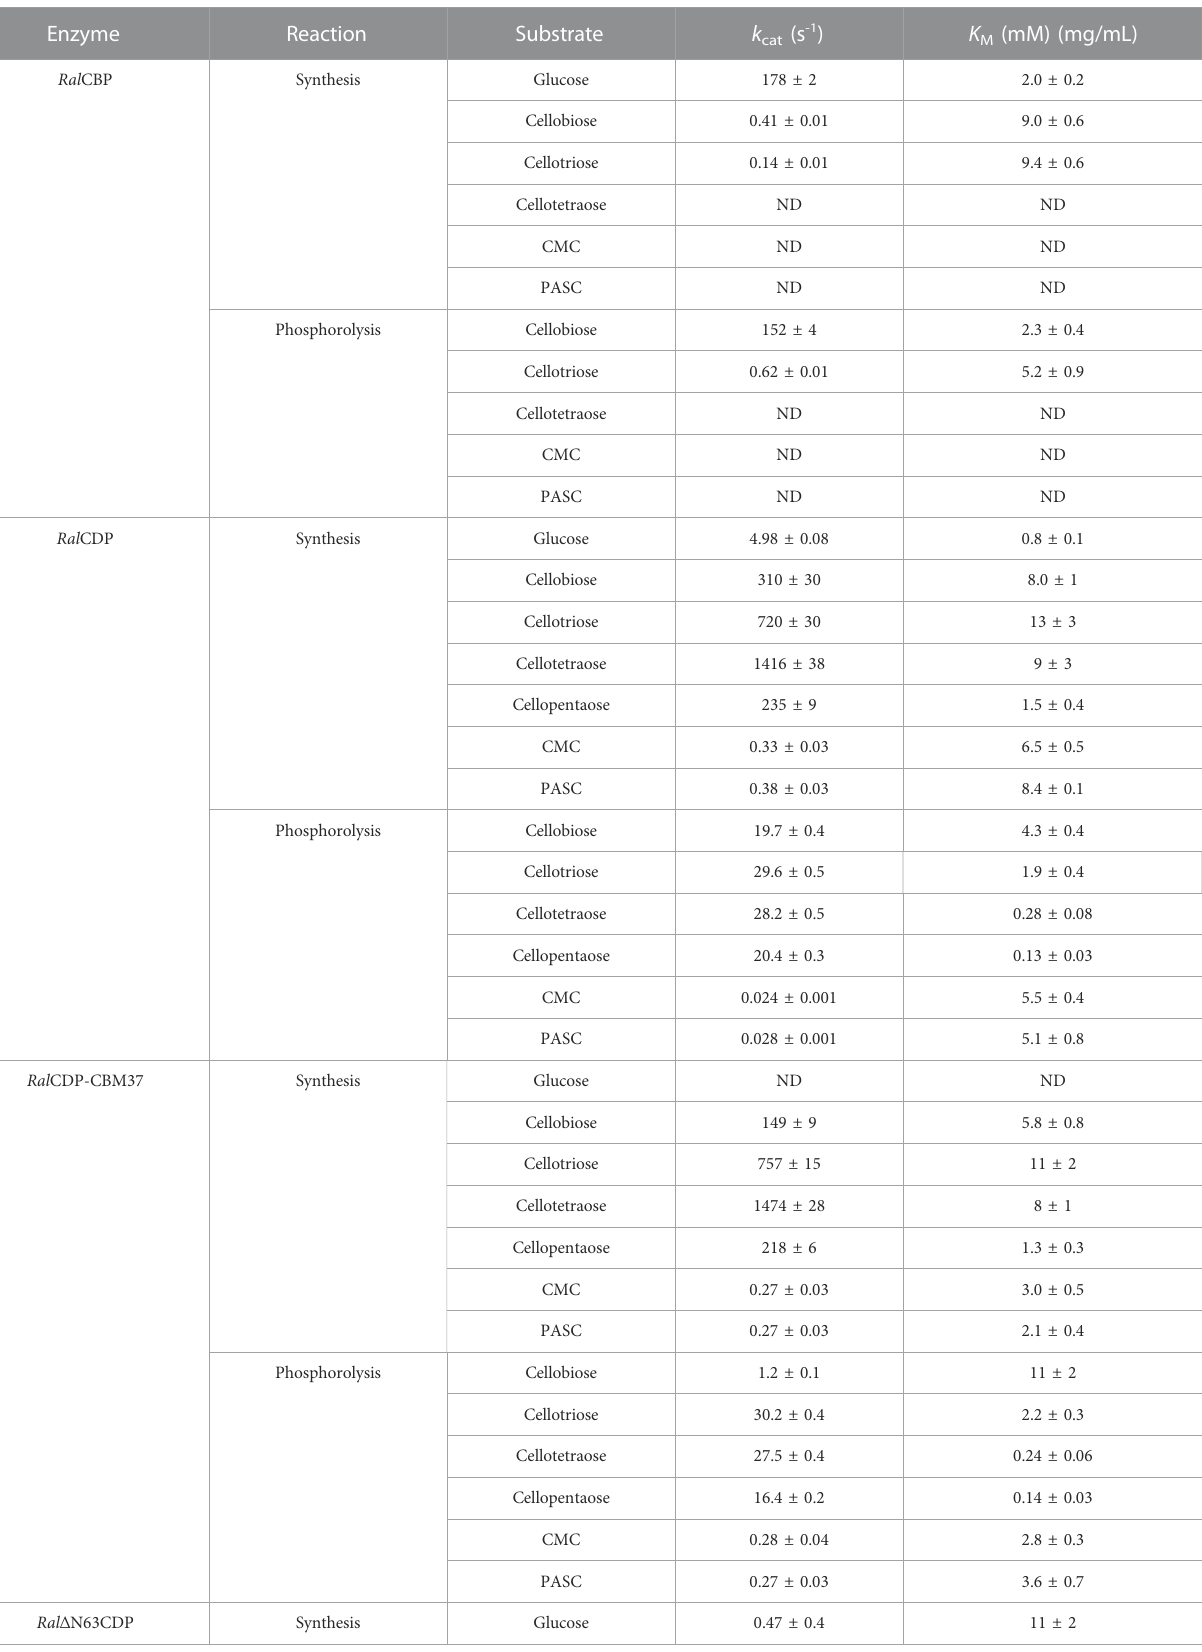
TABLE 1 Kinetic parameters from the different enzyme variants with substrates with different DP. a units for substrates CMC and PASC ND: Not detected activity even at a 50-fold increase in enzyme concentration.